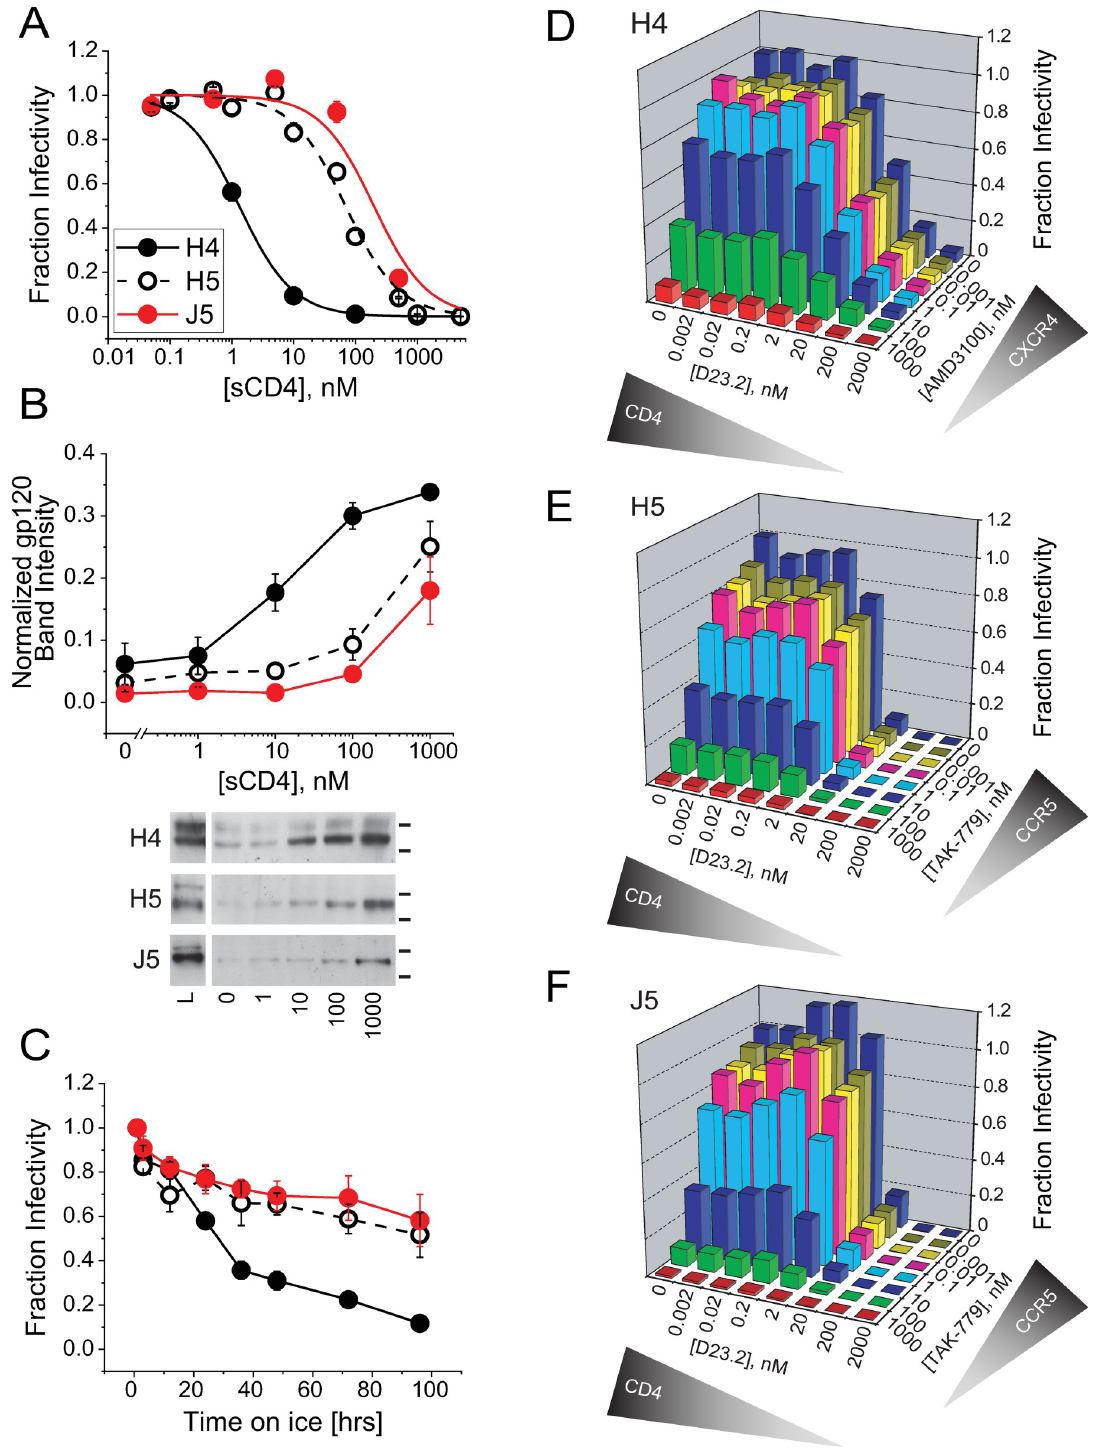
Fig 3. Chimeric H5 Env exhibits stability and CD4 sensitivity on par with tier 2-clade B primary isolate Env JRFL (J5). ( A ) Inhibitory titrations of soluble CD4 (sCD4) against HIV-1 pseudotyped with H4 Env (black filled symbols), H5 Env (black open symbols) or J5 Env (red symbols). ( B ) Soluble CD4 dependence to gp120 shedding from H4, H5 and J5 Env-expressing HEK293T cells. Shed gp120 was detected by SDS-PAGE/Western blot, quantified by densitometry and normalized to the total gp120 detected in cell lysates. In the images of representative Western blots (bottom), L denotes a 1:3 dilution of cell lysate; the lines to the right of the images indicate